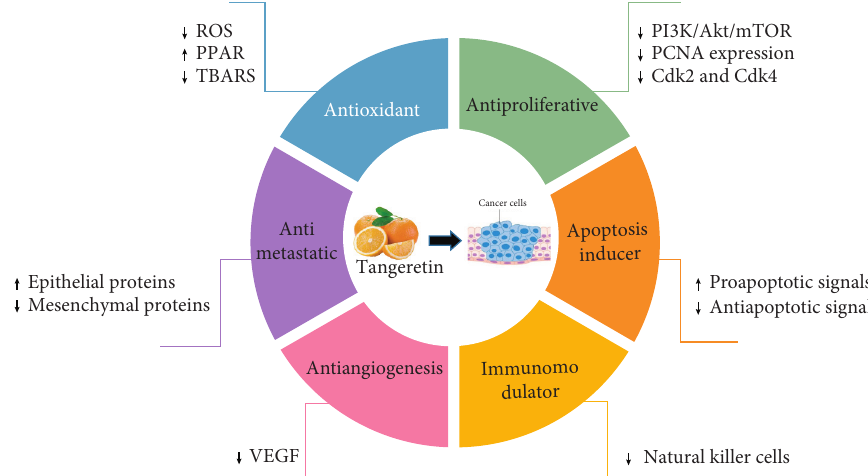
Figure 1: Mechanisms of the anticancer activity of tangeretin. Cdk2, cyclin-dependent kinases 2; Cdk4, cyclin-dependent kinases 4; PCNA, proliferating cell nuclear antigen; PI3K/Akt/mTOR, phosphatidylinositol 3-kinase/protein kinase B/mammalian target of rapamycin; PPAR, peroxisome proliferator-activated receptor; ROS, reactive oxygen species; TBARS, thiobarbituric acid reactive substances; VEGF, vascular endothelial growth